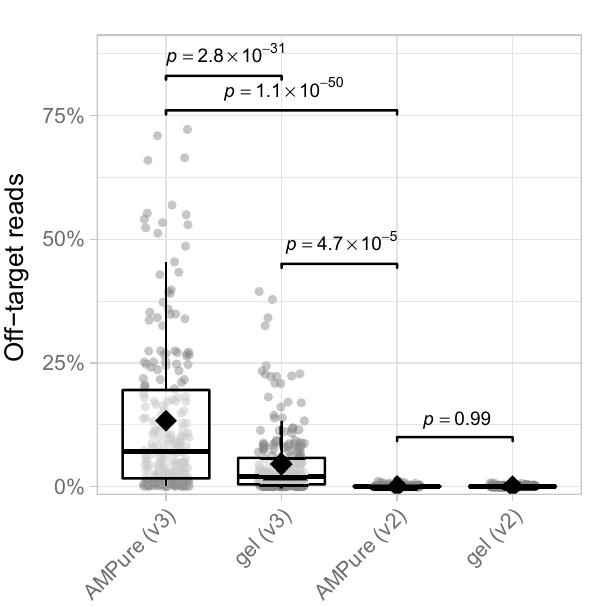
Figure 3. Off-target read percentage across MiSeq reagent kits and library purification methods. Significance was assessed using mixed linear models and the emmeans -package 18 to perform pairwise comparisons. Box plots represent the 25th and 75th percentiles (lower and upper boundaries of boxes, respectively), the median (middle horizontal line), and measurements that fall within 1.5 times the interquartile range (IQR; distance between 25 and 75th percentiles; whiskers). Means are shown as diamonds. n = 214 data points for each kit/ purification method